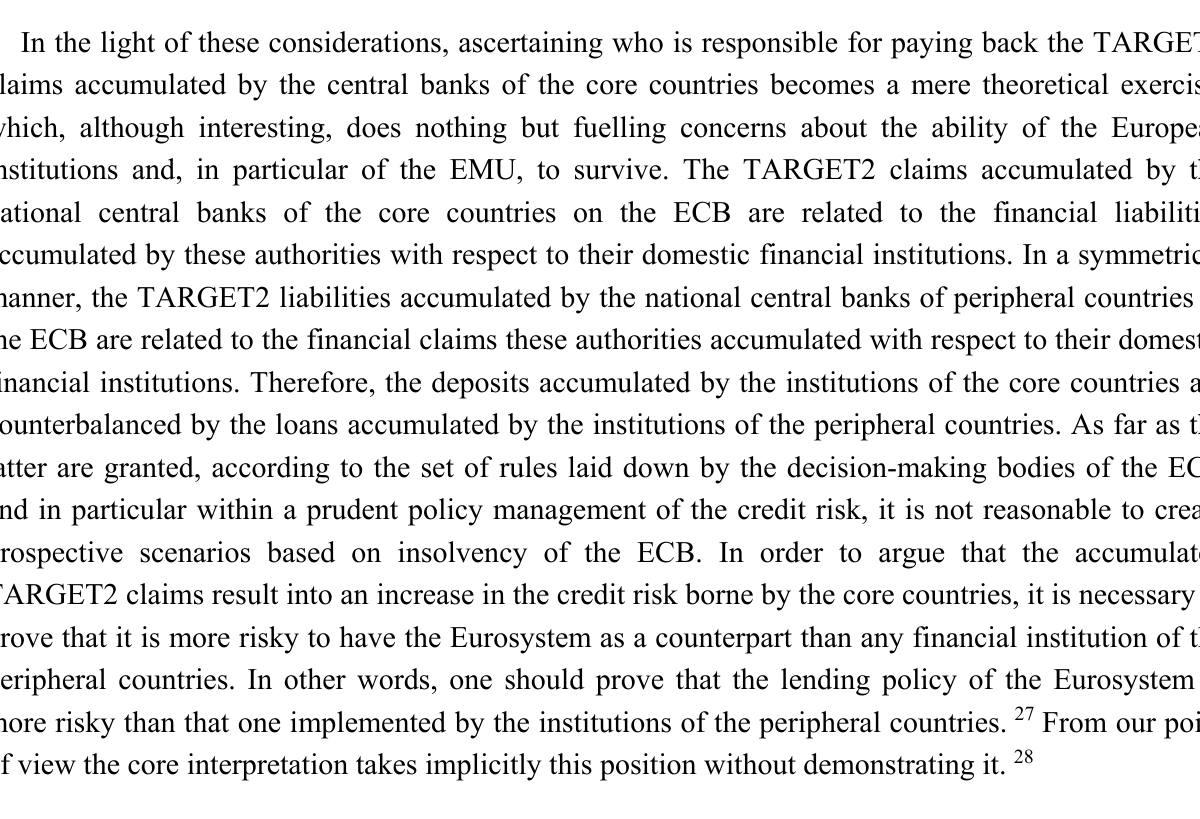
Figure 7. Consolidated financial statement of the Eurosystem (Euro billion, weekly, end of the period) Source: Elaboration on the ECB dataset (accessed on 27 June 2015,